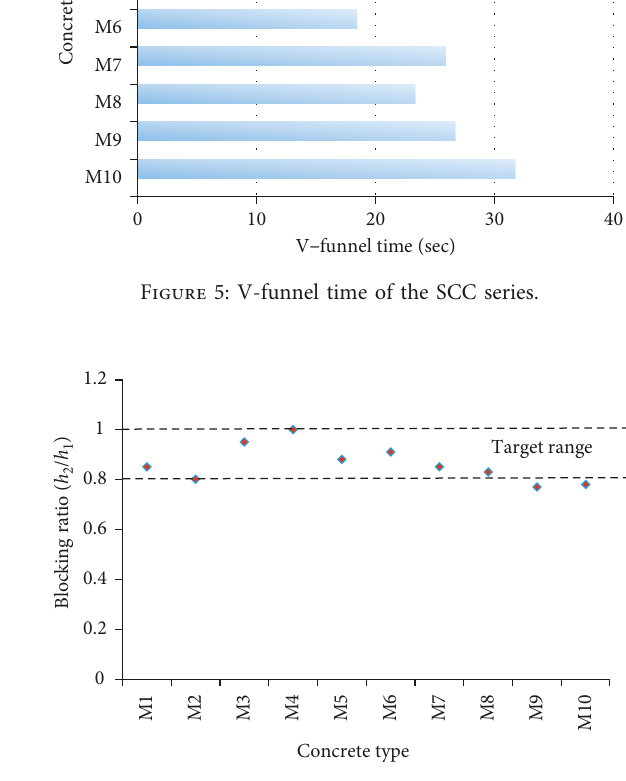
Figure 6: Blocking ratio of the SCC